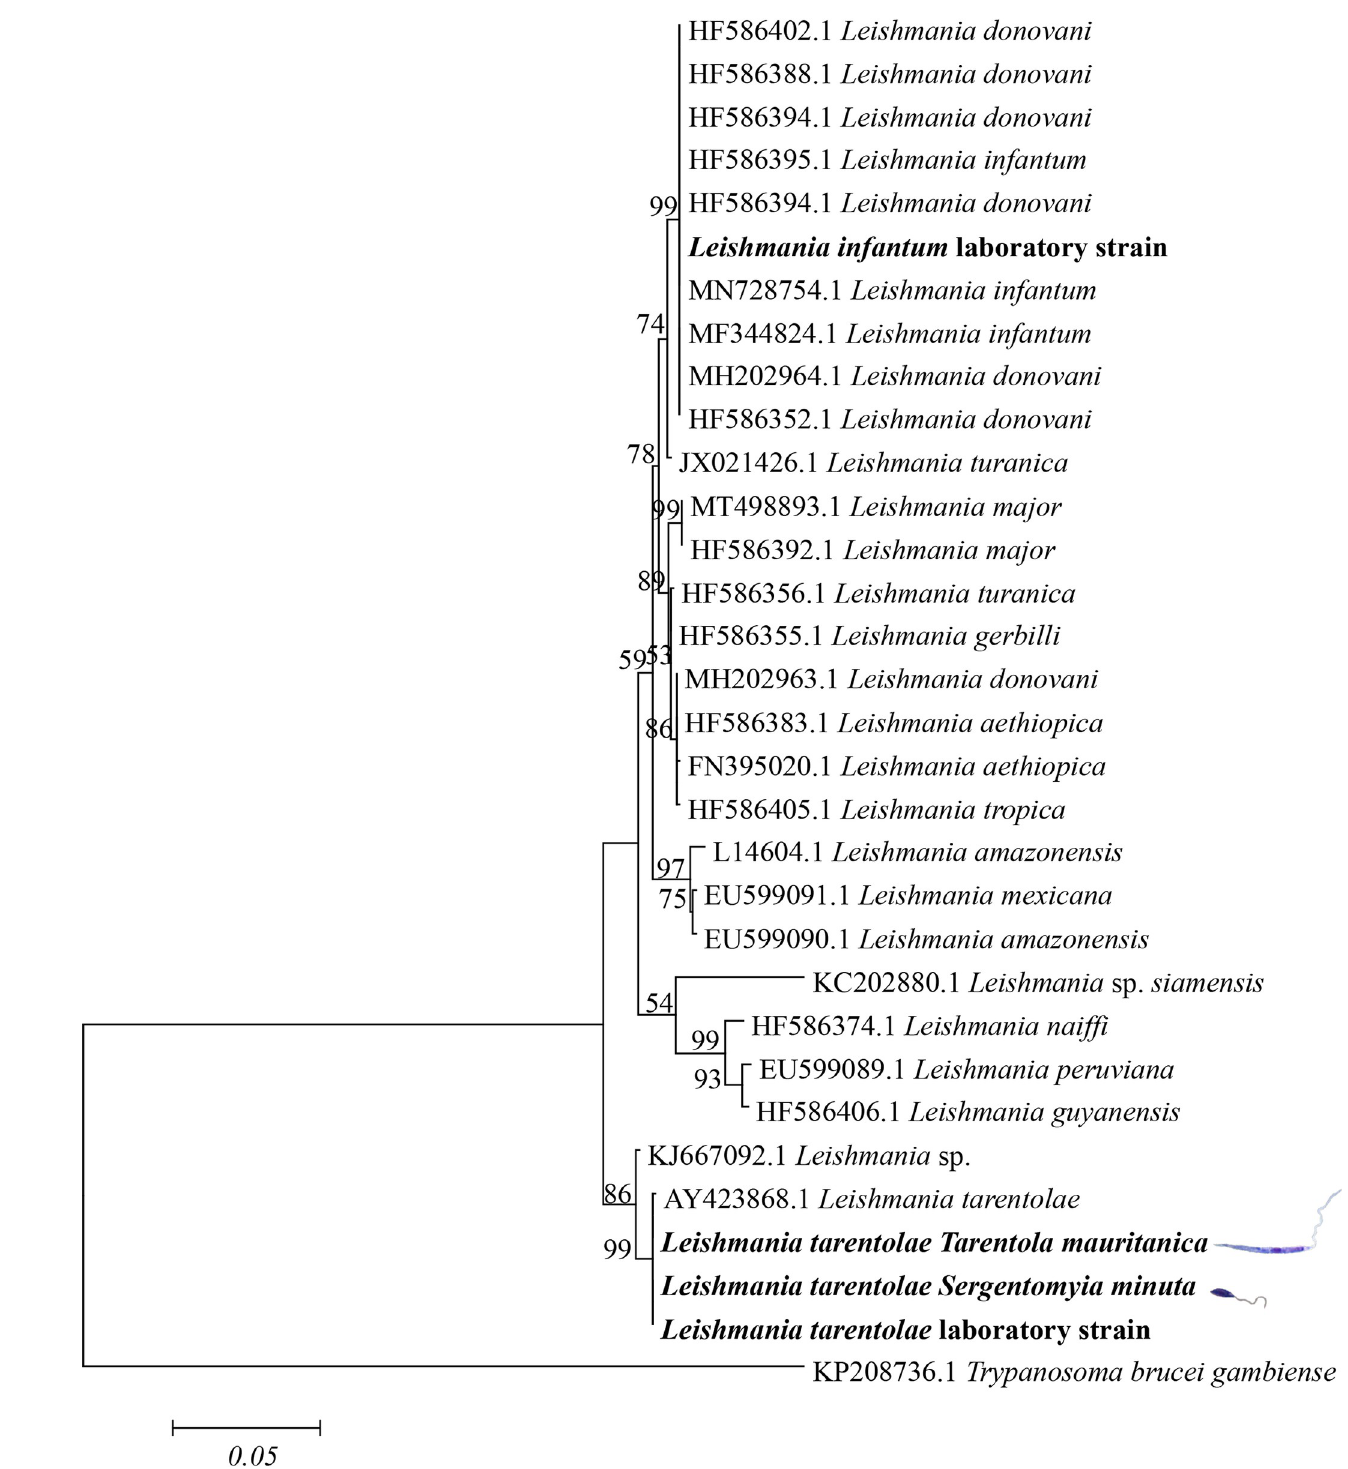
Fig 6. Phylogenetic tree based on Leishmania hsp 70 sequences inferred using the maximum likelihood method based on the Kimura 3-parameter model. Trypanosoma brucei gambiense was used as an outgroup. Scale bar indicates nucleotide substitution per site. The sequences of Leishmania spp. obtained in this study are in bold.